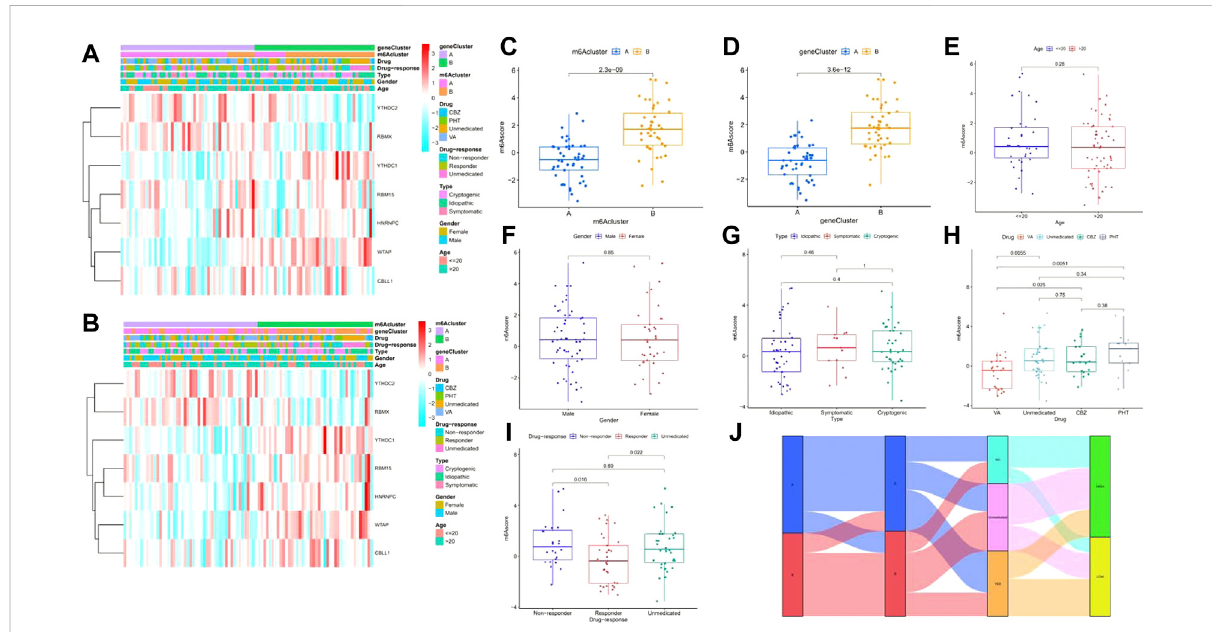
FIGURE 11 Relationship between the signature risk scores and clinical factors. (A – B) Heatmaps for the expression of 7 signi fi cant m6A regulators in m6A clusters and gene clusters with clinical features (age, gender, subtype, drug-response, and drug type). (C – I) The comparison of m6A score between oramongdifferentteams. (J) Sankeydiagramtoshowtherelationofm6Apatterns,m6A-relatedDEGspatterns,Drug-response,andm6Ascore* p < 0.01, ** p < 0.001, *** p < 0.0001.